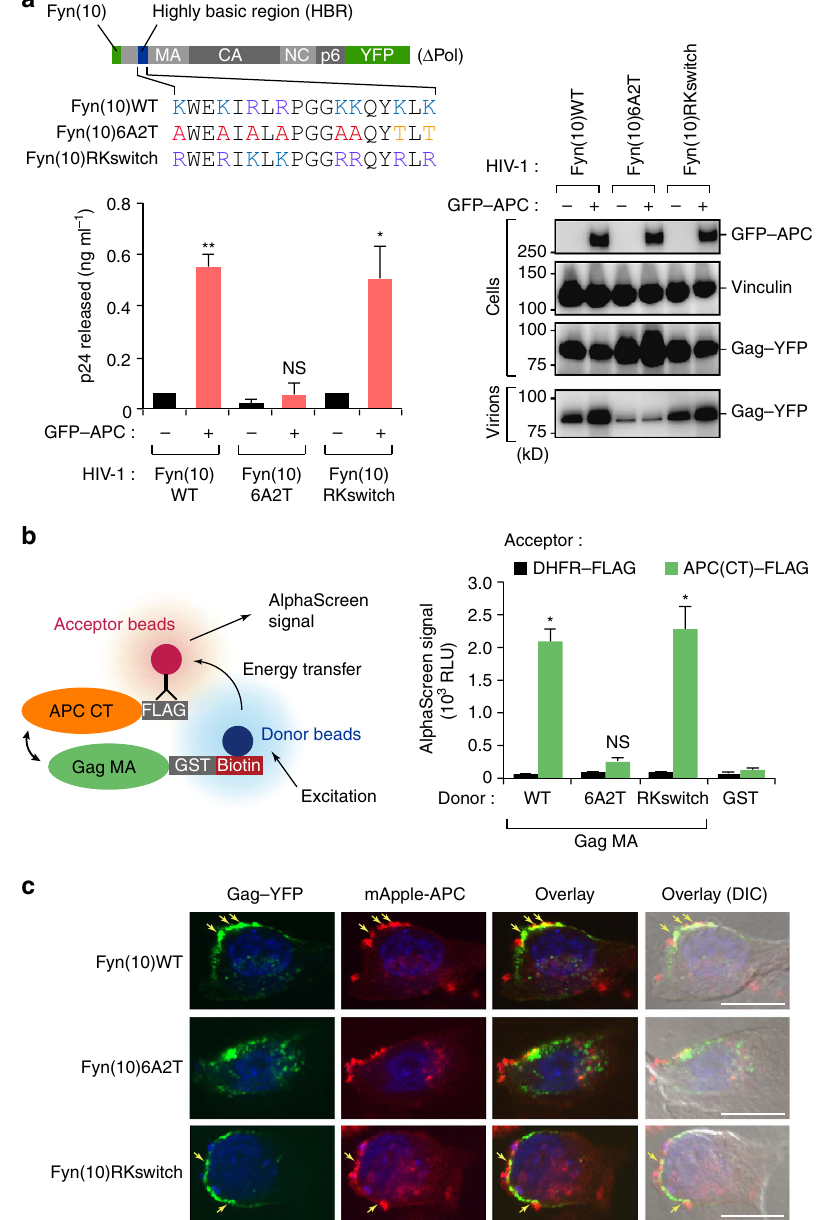
Figure 4 | The highly basic region in Gag MA is crucial for APC-mediated viral assembly. ( a ) Schematic representation of the pNL4-3-based derivative whose basic residues in Gag MA HBR were substituted by neutral residues (Fyn(10)-Gag(6A2T)-YFP) or with another basic residue (Fyn(10)-Gag(RKswitch)-YFP). HEK293 cells were transfected with these molecular clones and vectors encoding GFP–APC. At 48h following transfection, culture supernatants and cell lysates were analysed by p24 enzyme-linked immunosorbent assay and immunoblotting. ( b ) AlphaScreen assays of recombinant APC-CT and MA HBR mutants. DHFR and GST were used as negative controls. ( c ) A549 cells were transfected with indicated molecular clones and together with mApple-APC expression vector. At 24h following transfection, the cells were fixed and stained with 4,6-diamidino-2-phenylindole (nuclei, blue). Scale bar, 10 m m. The arrows indicate the co-localization of Gag and APC at the plasma membrane. All graphs are presented as a mean ± s.d. ( n ¼ 3). * P o 0.05, ** P o 0.01, two-tailed unpaired t -test. Full images for all immunoblots are provided in Supplementary Fig.